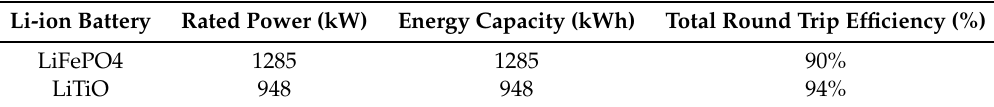
Table 2. Rated parameters of Li-ion batteries in a 20 ft container.